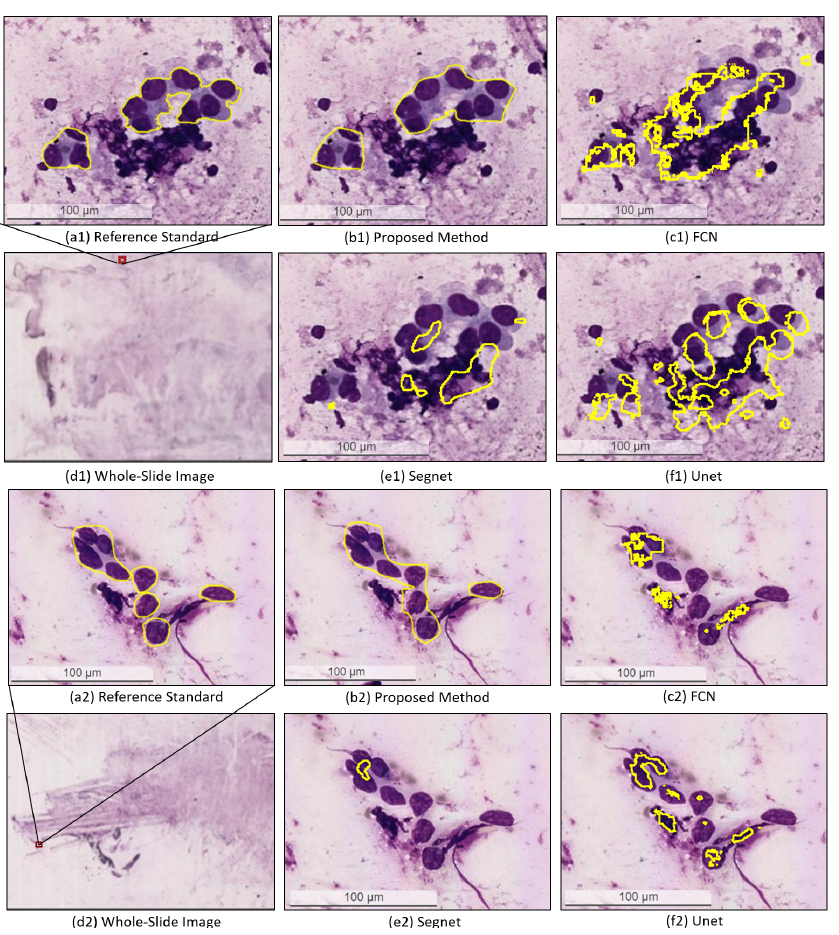
Figure 7. Visual comparison of the typical segmentation results generated by the proposed method and the three baseline methods (U-Net, SegNet, and FCN) for metastatic lesion segmentation in EBUS-TBNA WSIs.